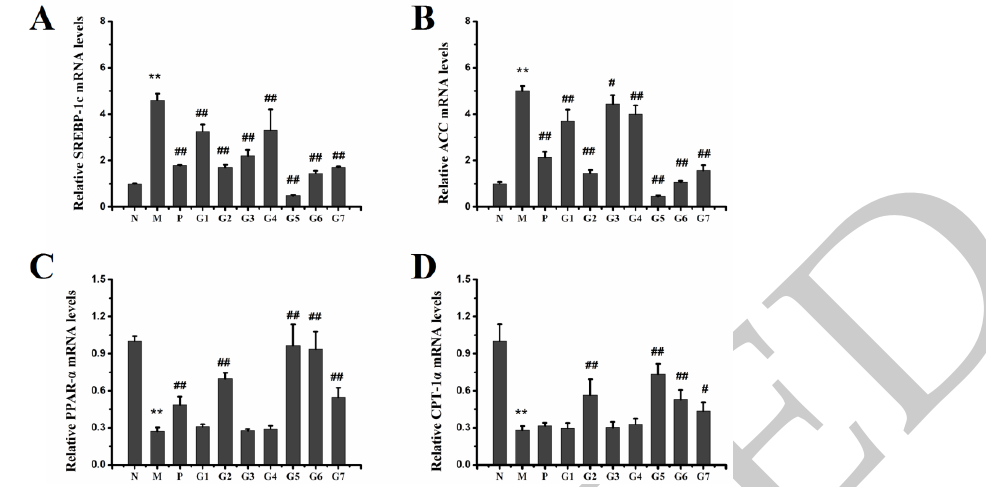
Figure 6. Hepatic mRNA expression of SREBP-1c ( A ); ACC ( B ); PPAR-α ( C ) and CPT-1a ( D ) in ALD